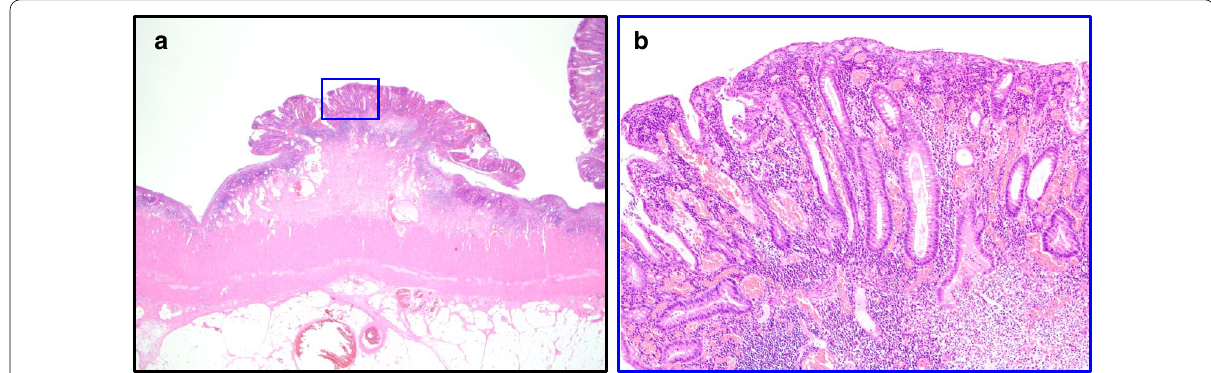
Fig. 7 Histological findings of the transverse colon. Residual mucosal islands were located between ulcerated areas ( a HE staining, 10 branching and irregularity of size and shape with chronic inflammatory cells were observed in some areas ( b HE staining, 100